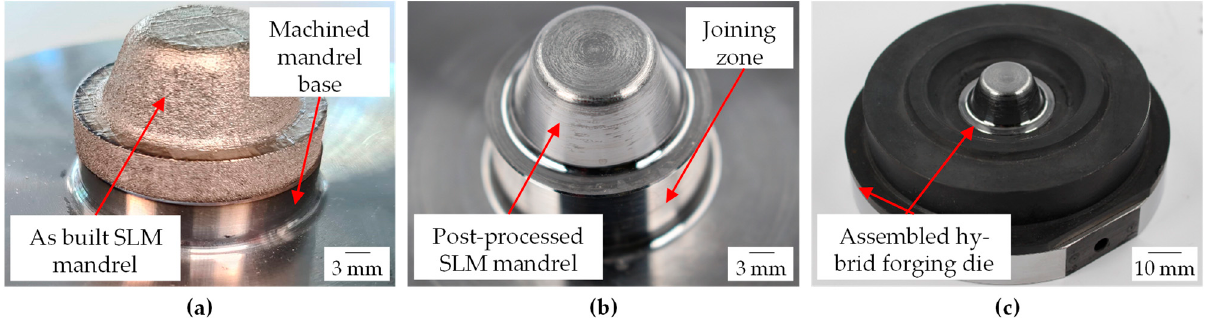
Figure 13. Prototype production of the hybrid-forging die: ( a ) mandrel in as-built condition; ( b ) postprocessed mandrel; ( c ) assembled hybrid forging die.